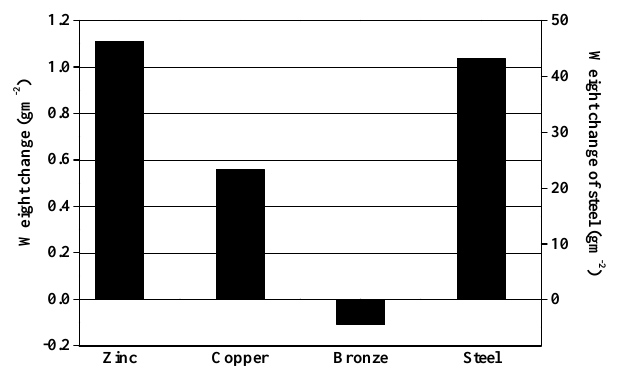
Fig. 5. Weight change of the specimens exposed for one year on the main rack (unsheltered).